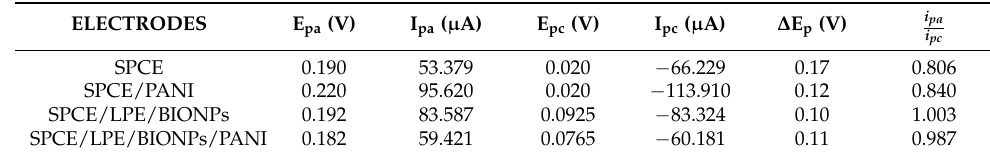
Table 2. The peak summary for the comparative voltammogram of the SPCE, SPCE/LPE/BiONPs and SPCE/LPE/BiONPs/PANI in the probe.